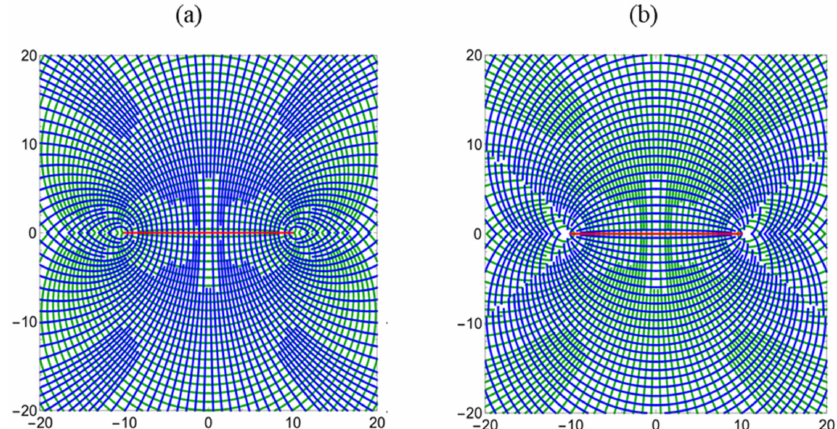
Figure 12. Stress trajectory patterns around hydraulic fractures without any regional stress anisotropy. ( a ) During fracture treatment, when over-pressure must exist for the fracture opening and proppant emplacement. ( b ) During flow-back, when under-pressure conditions prevail. Blue trajectories are for the largest principal stresses (deviatoric compression τ 1 = σ 1 − P ). Green trajectories are for smallest principal stresses (deviatoric tension, τ 3 = σ 3 − P